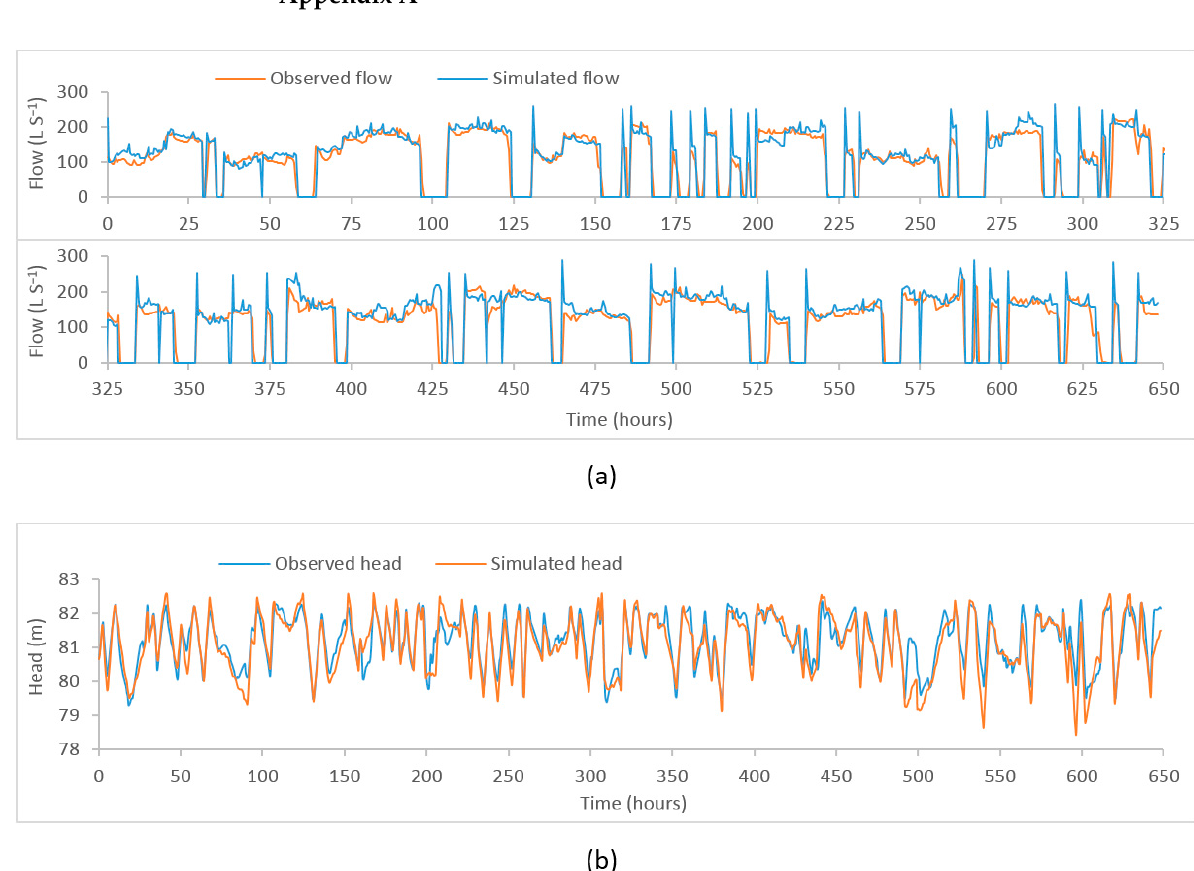
Figure A1. Plot of observed and model ‒ simulated time ‒ series. ( a ) Flow at PS1 ( b ) head at Coomandook tank.